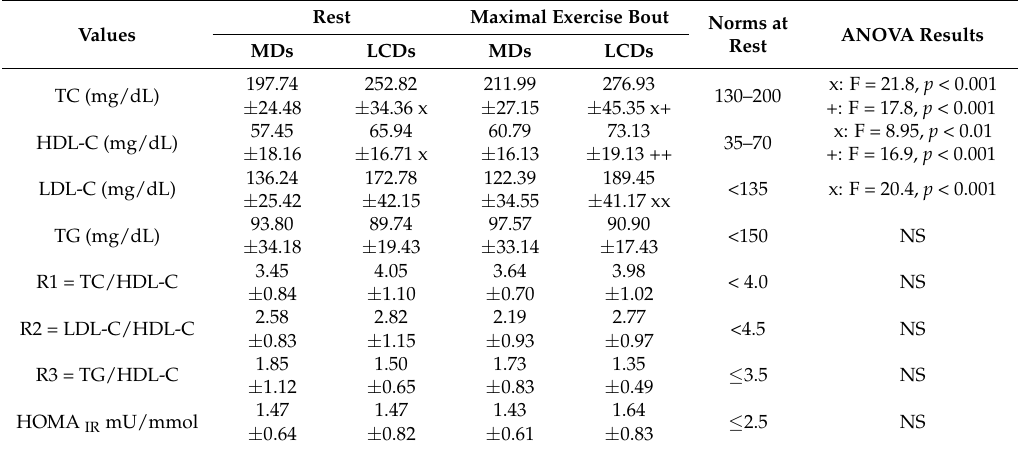
Table 4. Biomarkers of cardiovascular disease (CVD) risk estimated in fasting blood samples of participants in the low carbohydrate diets (LCDs) and mixed diets (MDs) groups. Values